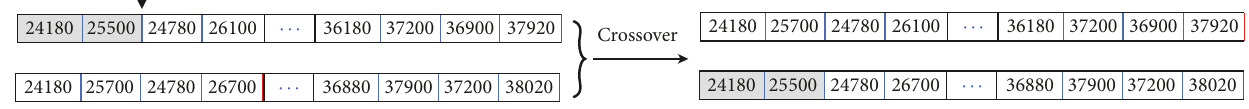
Figure 5: Crossover